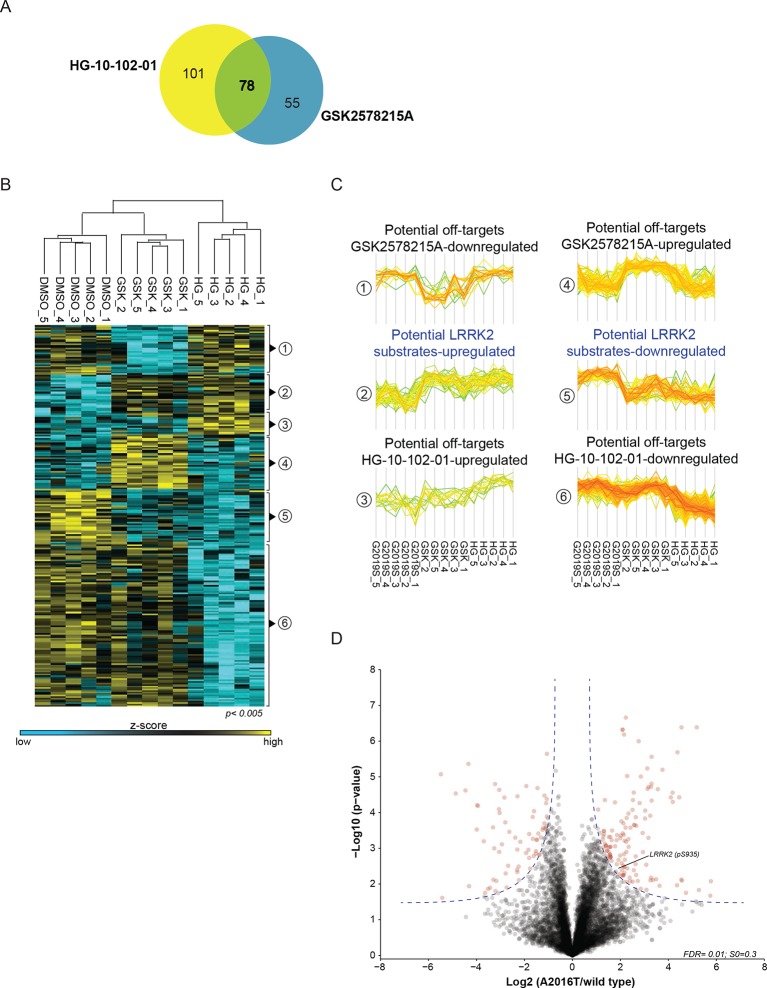
Two unbiased phosphoproteomic screens identify physiological LRRK2 targets.(A) Venn diagram of significantly regulated (ANOVA, p<0.005) sites with GSK2578215A and HG-10-102-01 in PS1. (B) Heat map of regulated phosphosites identified in five biological replicates of MEFs (LRRK2-G2019SGSK (DMSO), LRRK2-G2019SGSK+ GSK2578215A. and LRRK2-G2019SGSK + HG-10-102-01). (C) Clusters identified in (B). (D) Volcano plot of all phosphosites of PS2. Significant sites are in blue and pS935 is indicated. ANOVA, analysis of variance.